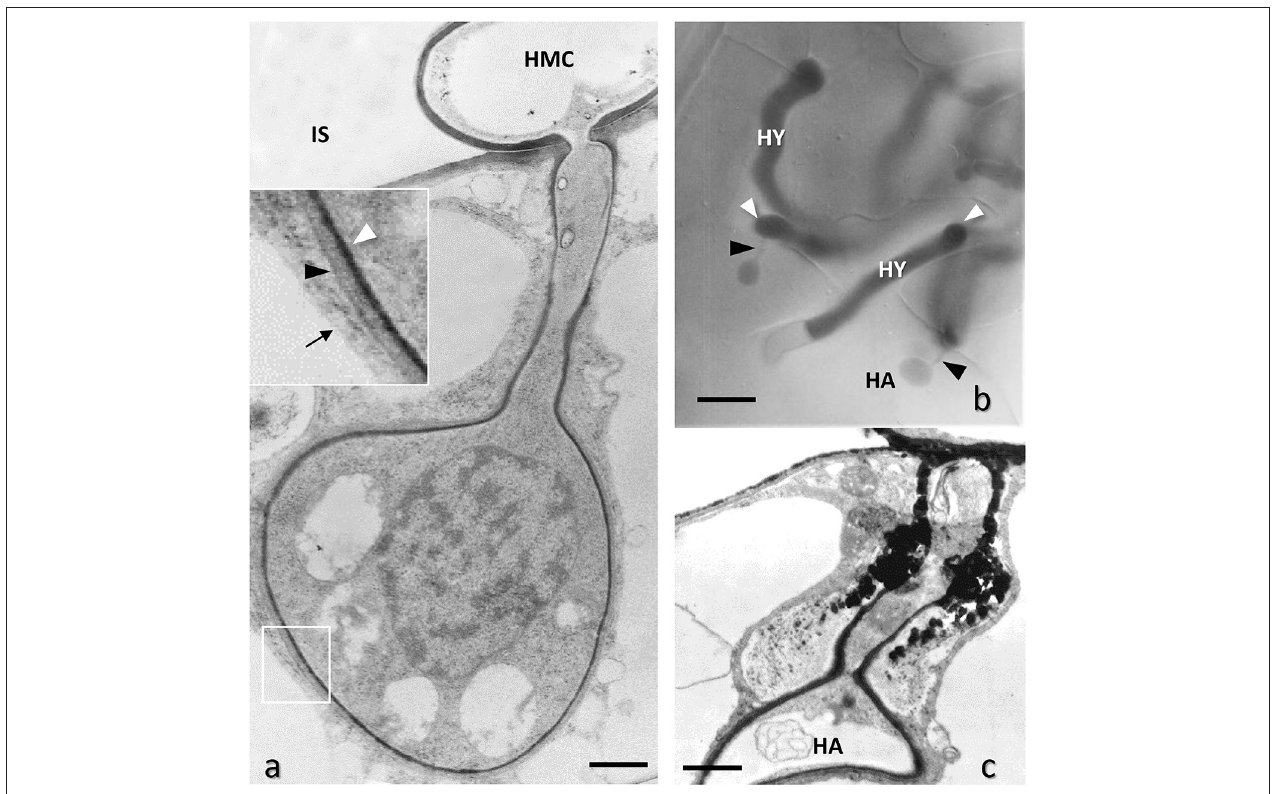
FIGURE 8 | Leaf mesophyll cells of Phaseolus vulgaris infected with bean rust by Uromyces appendiculatus , Basidiomycota. (a) TEM image of a globose haustorium (HA) generated by a haustorial mother cell (HMC) in the intercellular space (IS); the framed area is enlarged in the inset, showing a thin layer of an extra-haustorial matrix between a fungal cell wall (white arrowheads) and host plasma membrane (black arrowhead), the latter appearing thickened, while the close tonoplast membrane (arrow) is normal. Bar, 1.0 µ m. (b) Interference-contrast light microscopy of the fungal hyphae growing in the mesophyll intercellular space and generating haustoria (HA) connected to the haustorial mother cell by a thin neck (black arrowheads). Bar, 10 µ m. (c) TEM image of a collapsing haustorium (HA) due to the secretion of toxic polyphenols (PH) in the extra-haustorial matrix around the neck by plant resistance mechanisms. Bar, 1.0 µ